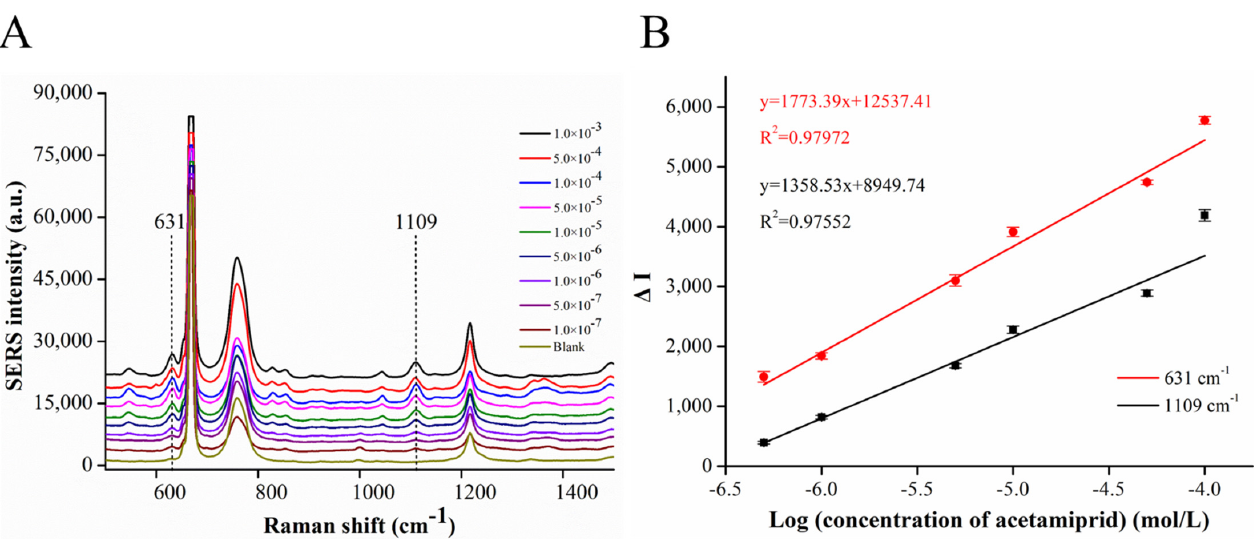
Figure 6. ( A ) SERS spectra of acetamiprid with concentrations from 0 to 1.0 × 10 − 3 mol/L collected with the self-assembled Au NP array as the enhancing substrate; ( B ) Standard curves of the developed SERS method for acetamiprid quantification (5.0 × 10 − 7 mol/L to 1.0 × 10 − 4 mol/L) based on the intensities of the Raman shifts at 631 cm − 1 and 1109 cm − 1 .